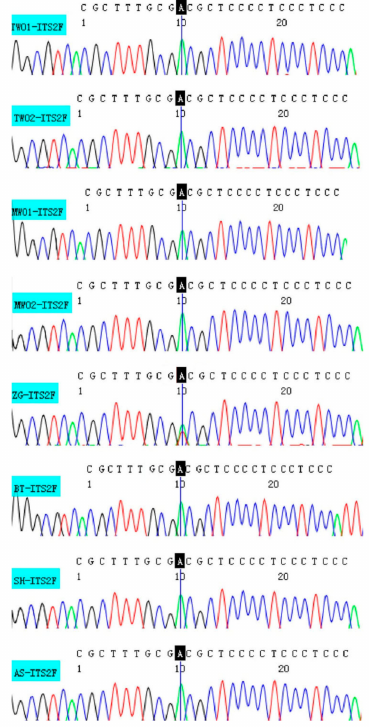
Figure 4. Single nucleotide polymorphisms (SNP) peaks of four batches of Chinese patent medicine containing